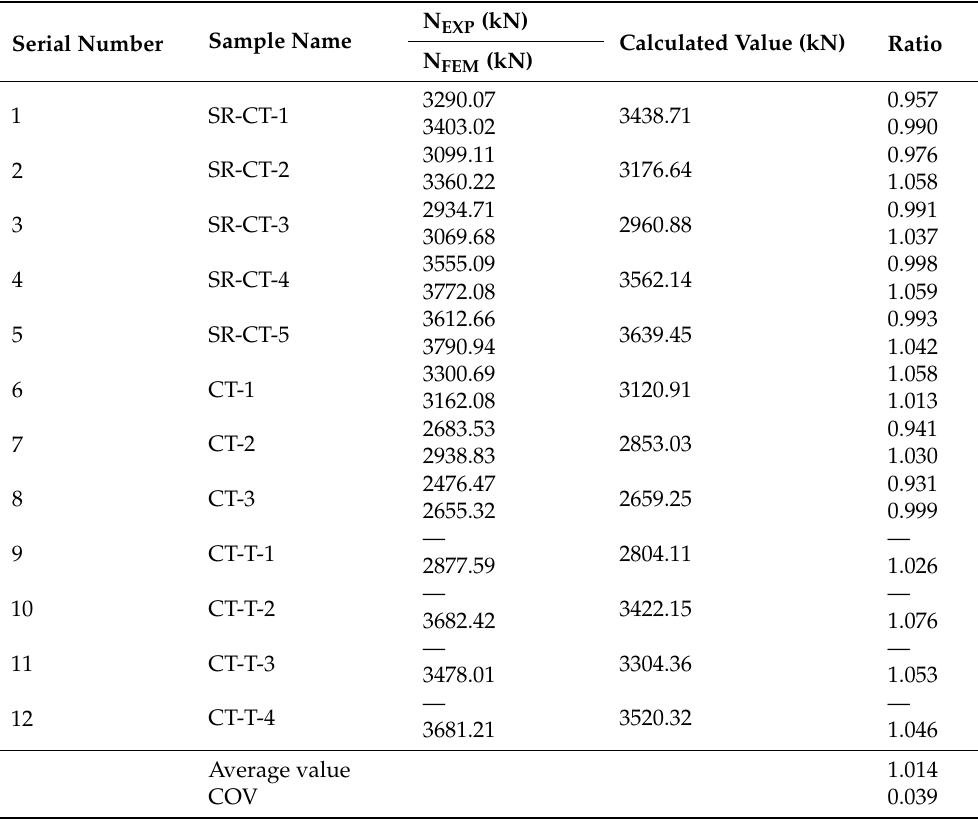
Figure 22. Axial compression bearing capacity comparison. Table 9. Error analysis of test and simulated ultimate bearing